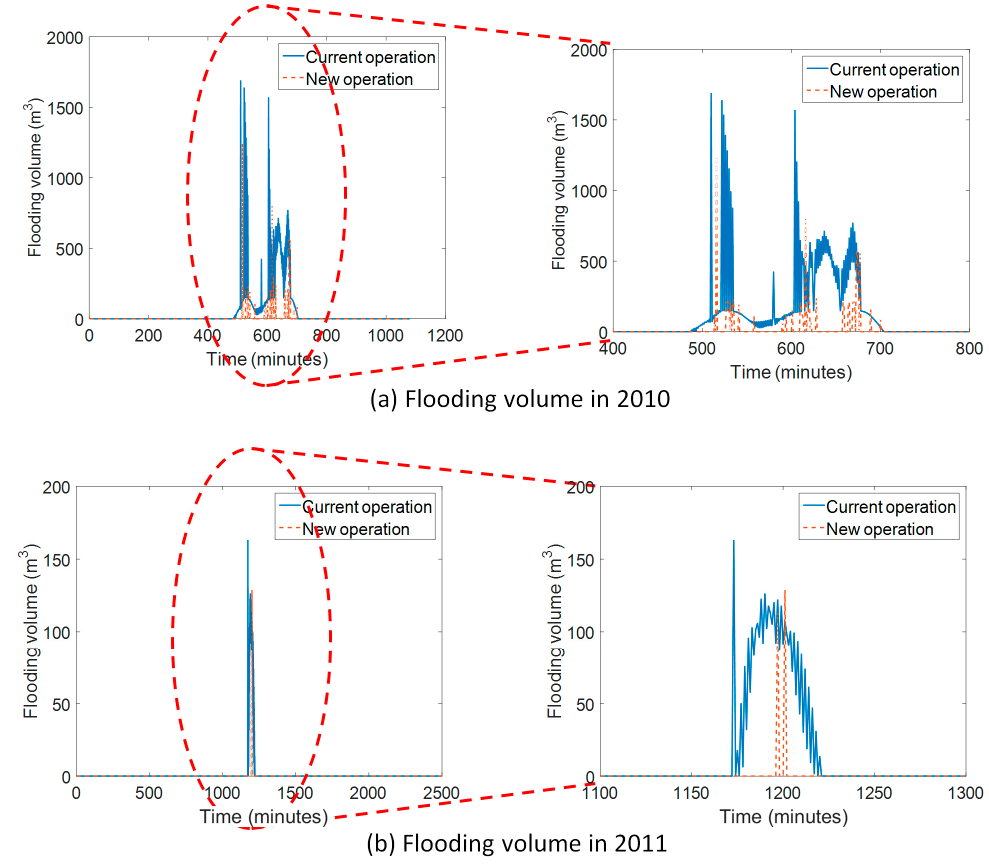
Figure 11. Flooding volumes over time for the current and new operations in ( a ) 2010 and ( b ) 2011.